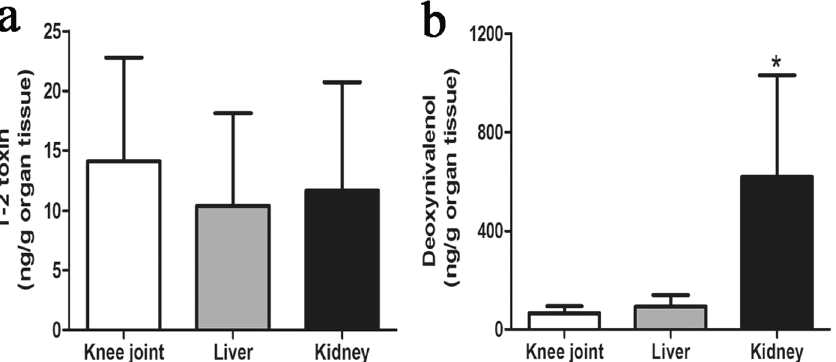
Figure 8. The distribution of mycotoxins in the knee joint, liver, and kidney. Sprague-Dawley rats were administered a single dose of ( a ) T-2 toxin at 2 mg/kg bw or ( b ) DON at 10 mg/kg bw by oral gavage and tissues were harvested after 8 h analyzed for mycotoxin concentrations. Data are represented as mean ± SD (n = 6); * P < 0.05 indicates significant difference in DON concentration in the kidney versus knee joint and liver